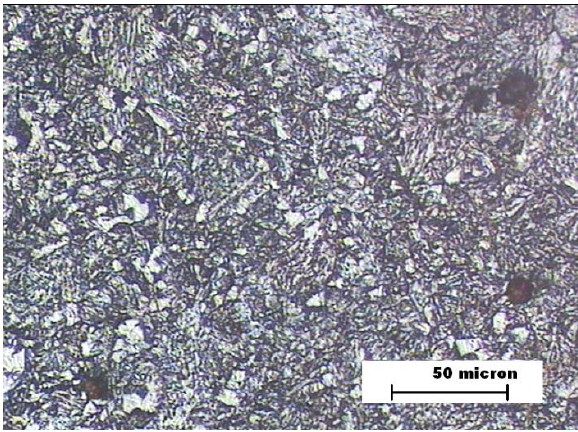
Figure 7. Sample B. FZ microstructure.